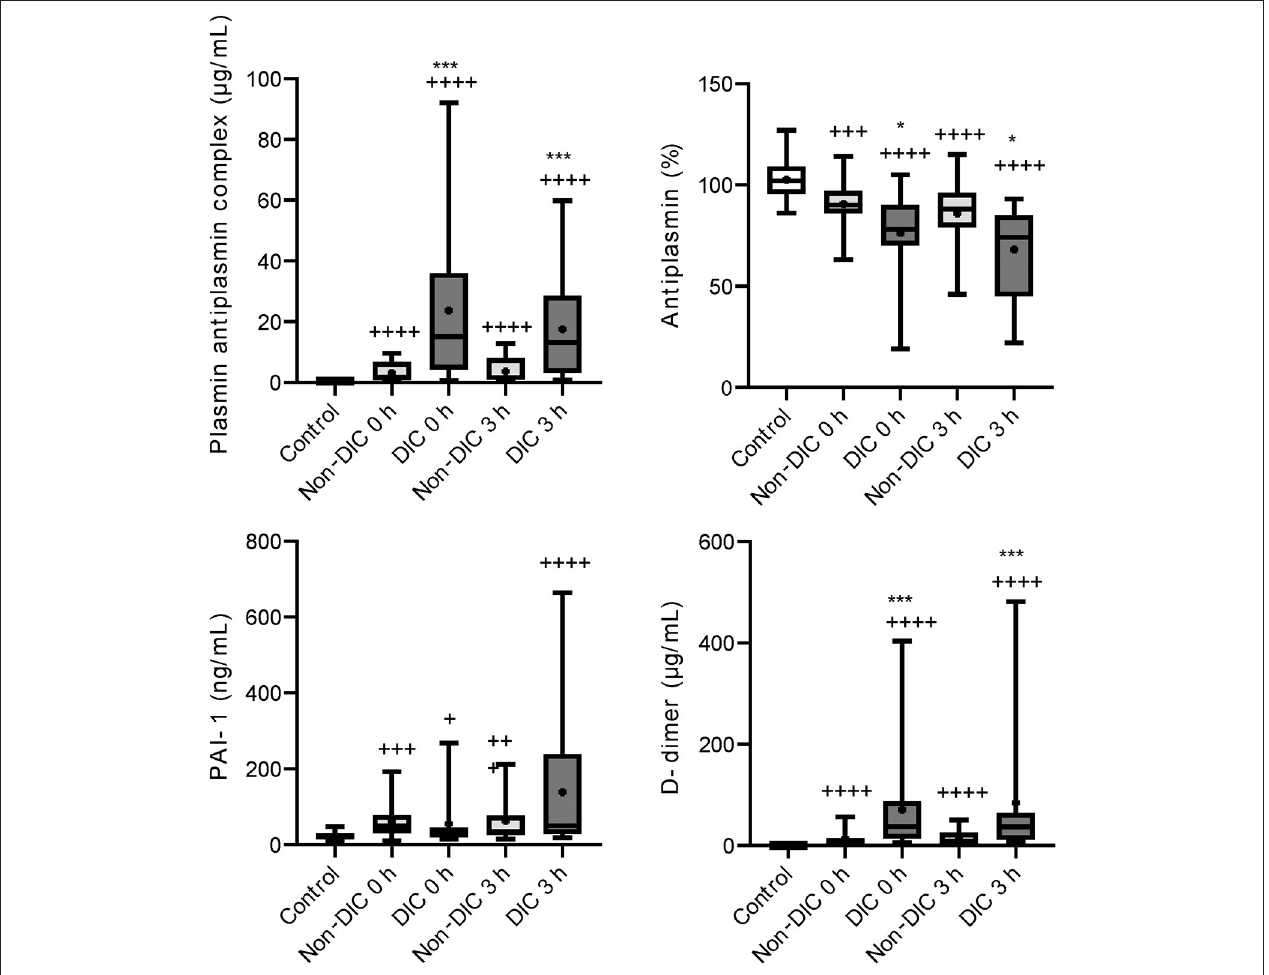
FIGURE 6 | Serial changes in the fibrinolysis-related molecular markers in patients with isolated traumatic brain injury. Healthy controls (white box), non-disseminated intravascular coagulation (DIC) (light gray boxes) and DIC (dark gray boxes) at presentation to the emergency department (0h) and 3h after hospital arrival (3h). Horizontal bars in the box indicate the median (middle) and interquartile ranges (upper 25% and lower 75%). Black boxes represent the mean values. + p < 0.005 vs. healthy controls, ++ p < 0.001 vs. healthy controls, + + + p < 0.001 vs. healthy controls, + + ++ p < 0.0001 vs. healthy controls, * p < 0.05 vs. non-DIC, *** p < 0.001 vs.